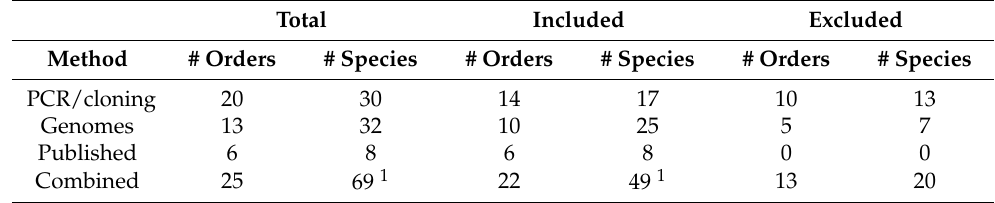
Table 1. Numbers of samples and orders examined for each data method. Total refers to all samples considered, “Included” are those used in analyses and “Excluded” are those where it was not clear whether two gametologs had been identified, and so these were not included in the analyses. See Supplementary Files S1 and S2 for full data. “PCR/cloning” refers to samples we amplified using PCR and cloned to identify gametologs. “Genomes” refers to chromosomal-level assemblies of females that were examined for presence of Z and W sequences. “Published” refers to sequences from Carmichael et al. [41] and Suh et al. [22] that were downloaded from GenBank.